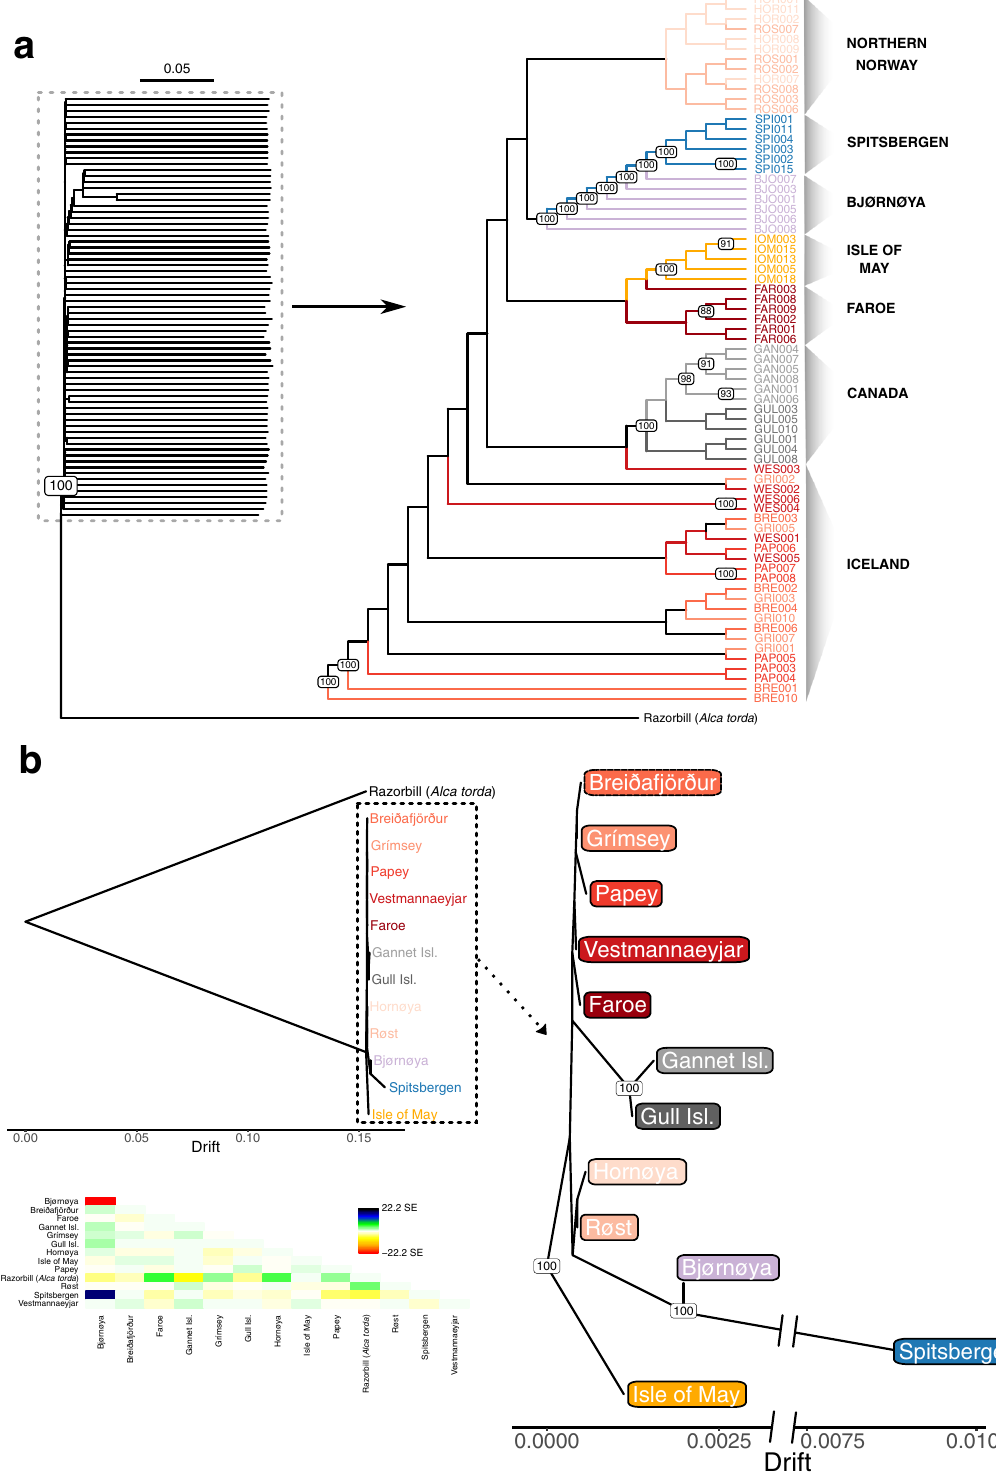
Fig. 2 Phylogenetic reconstruction of individual and colony relationships from 71 Atlantic puf fi n individuals sampled across 12 colonies throughout the species ’ breeding range. a An individual-based neighbor-joining tree constructed using pairwise p-distances calculated from genotype likelihoods at 1,093,765 polymorphic nuclear sites. Branch lengths and the outgroup were removed for the zoomed-in section to improve visualization. b A population-based maximum likelihood Treemix analysis using allele frequencies at the same 1,093,765 polymorphic nuclear sites as in ( a ). Both trees are rooted using the razorbill as an outgroup. The tree in ( b ) is visualized with and without the outgroup. Branch lengths are equivalent to a genetic drift parameter. The heatmap indicates the residual fi t of the tree displaying the standard error of the covariance between populations. In ( a ) and ( b ), the color coding of the colonies is consistent with those in Fig. 1 and node labels show bootstrap support >80. The dataset(s) needed to create this Figure can be found at https://doi.org/10.6084/m9. fi